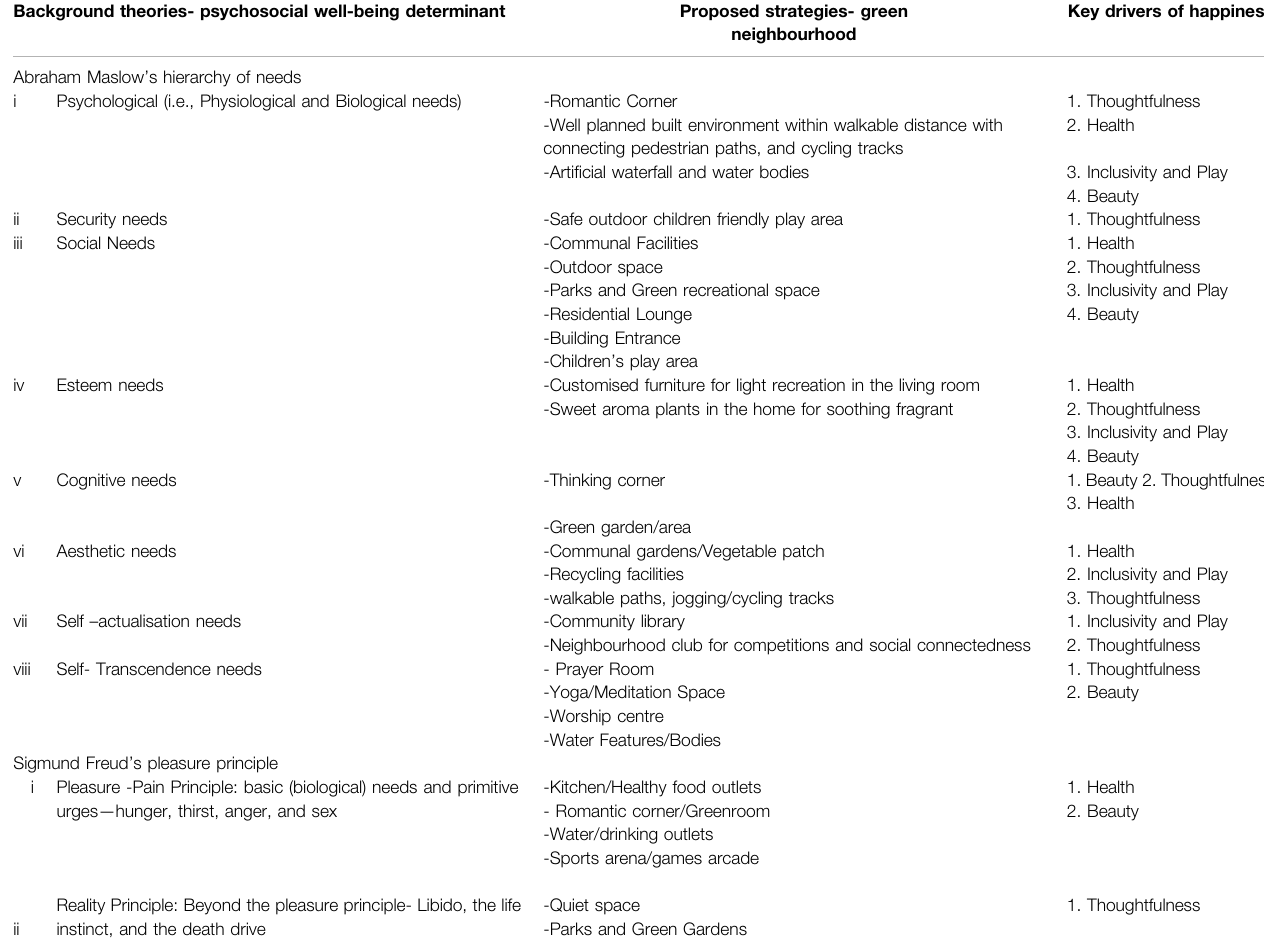
TABLE 3 | The input of psychosocial well-being determinants in a green neighbourhood to produce happiness. Background theories- psychosocial well-being